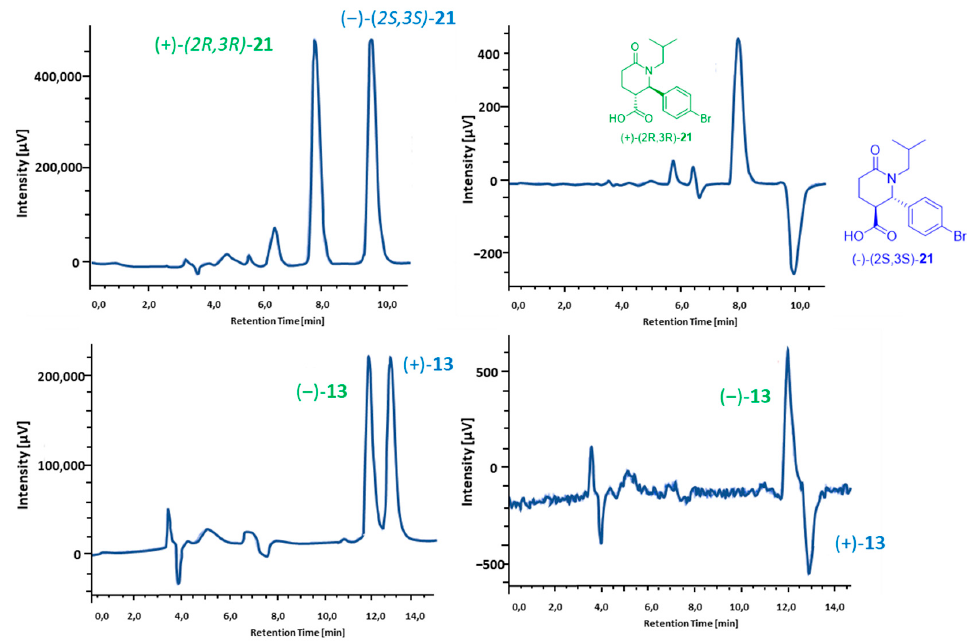
Figure 4. On the ( left ): UV Chromatographic profile at 220 nm; on the ( right ): ECD trace; Chiralpak IA, mobile phase n -Hex/IPA/DEA/TFA 90:10:0.1:0.3 ( v/v / v/v ), flow rate 1 mL/min) of ( − )- 13 and (+)- IA, mobile phase n -Hex/IPA/DEA/TFA 90:10:0.1:0.3 ( v / v / v / v ), flow rate 1 mL/min) of ( − )- 13 and 13 above and (+)- (2R,3R) - 21 and ( − )- (2S,3S) - 21 . (+)- 13 above and (+)-( 2R,3R )- 21 and ( − )-( 2S,3S )- 21